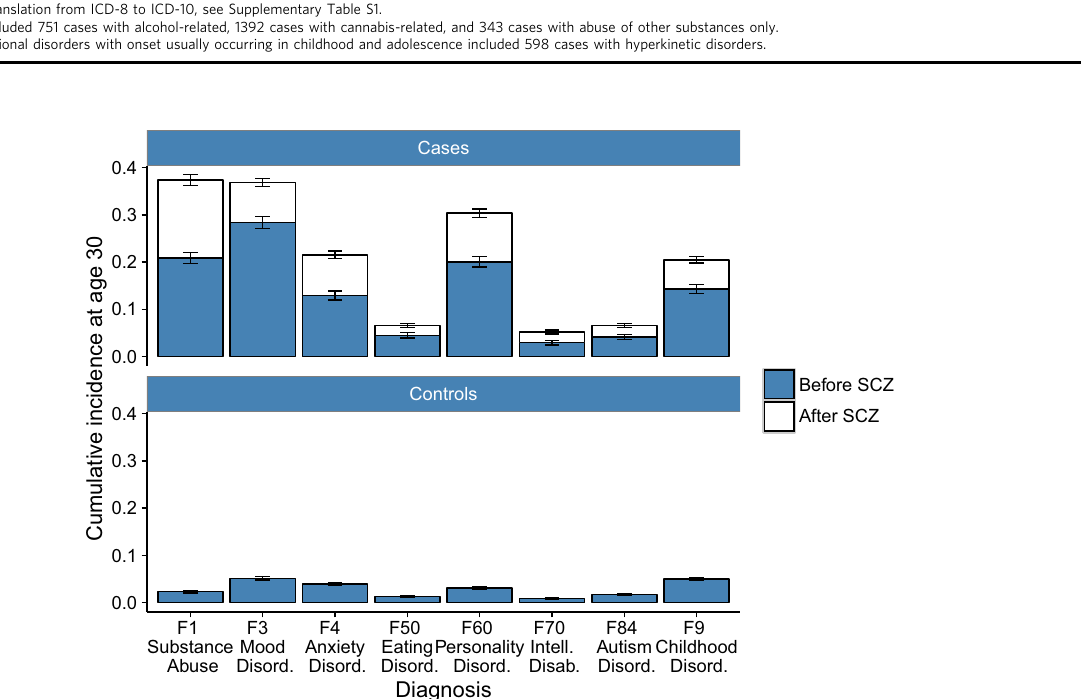
Fig. 1 Cumulative incidence at age 30 of eight comorbid psychiatric disorder categories in a Danish cohort of 5432 individuals with schizophrenia and 10,864 random population controls. The fi gure shows the cumulative incidence (CI) at age 30 of each of eight categories of comorbidities in individuals with schizophrenia and in the random population sample without schizophrenia. In blue are the CI before schizophrenia, in white are CI after schizophrenia. Error bars are 95% con fi dence intervals. The exact number of observed comorbidities are provided in Table